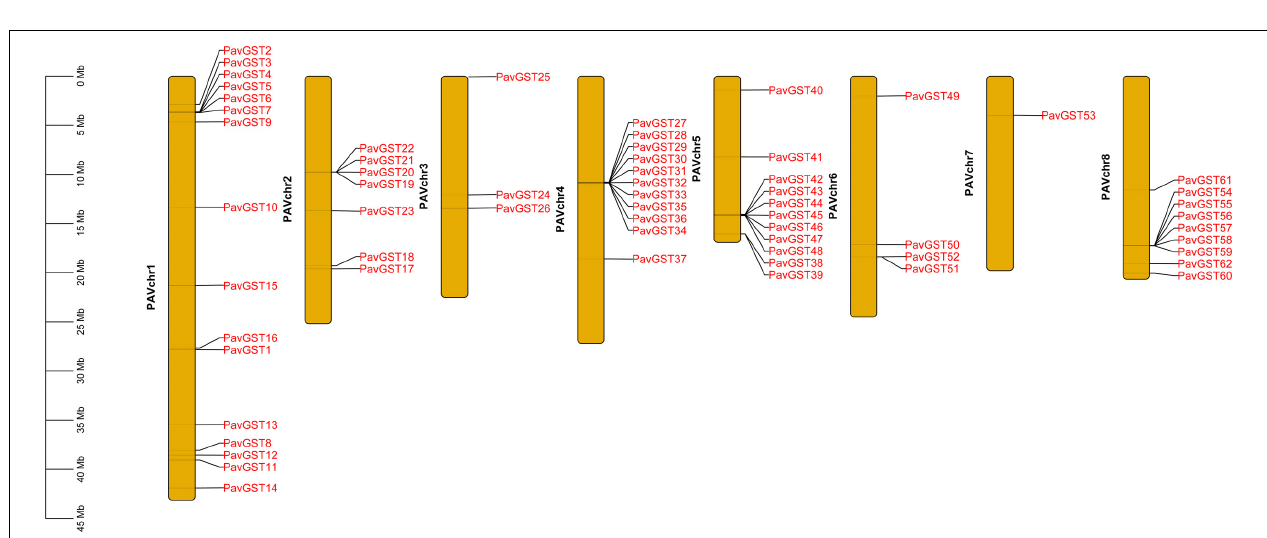
FIGURE 6 | (A) Collinearity relationship among Prunus avium and Arabidopsis thaliana . (B) Collinearity relationship of GST genes in Prunus avium and other Rosaceae species ( Prunus persica, Prunus avium, Prunus mume , and Fragaria vesca ).